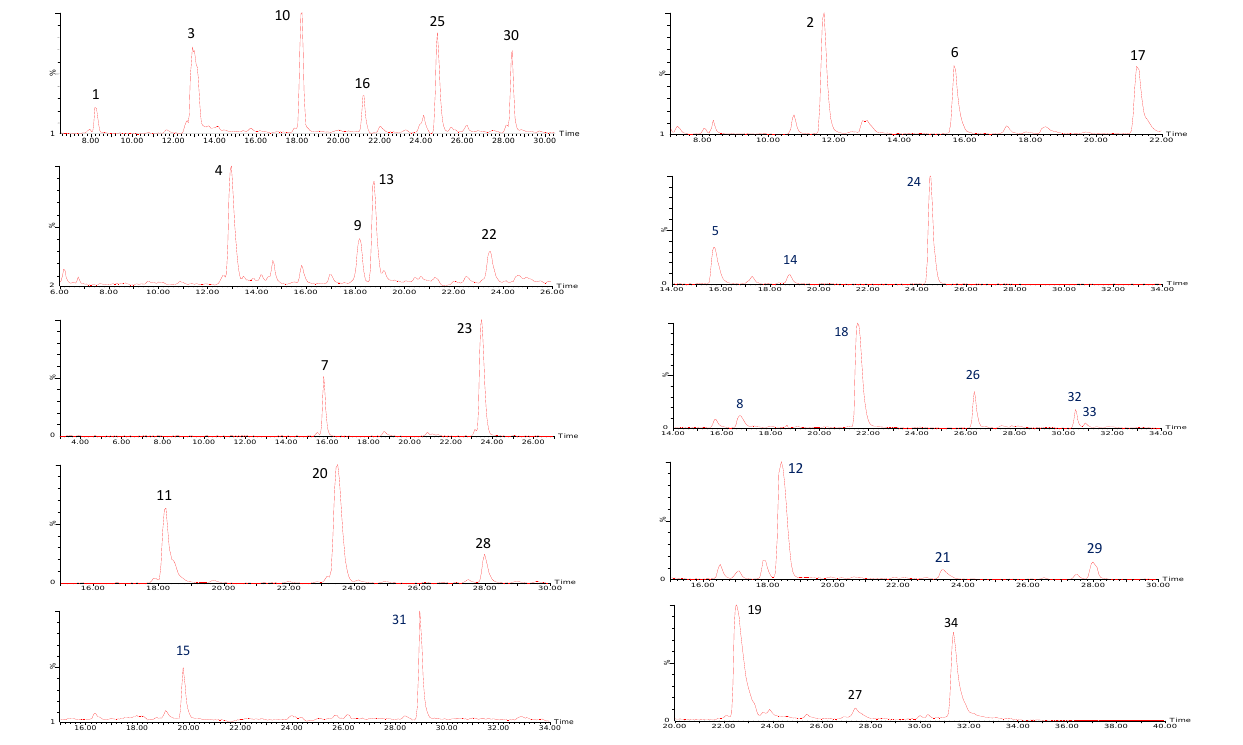
Figure 1. UHPLC QTOF-ESI MS Extracted ion chromatograms of phenolic compounds from Z. officinale rhizomes.